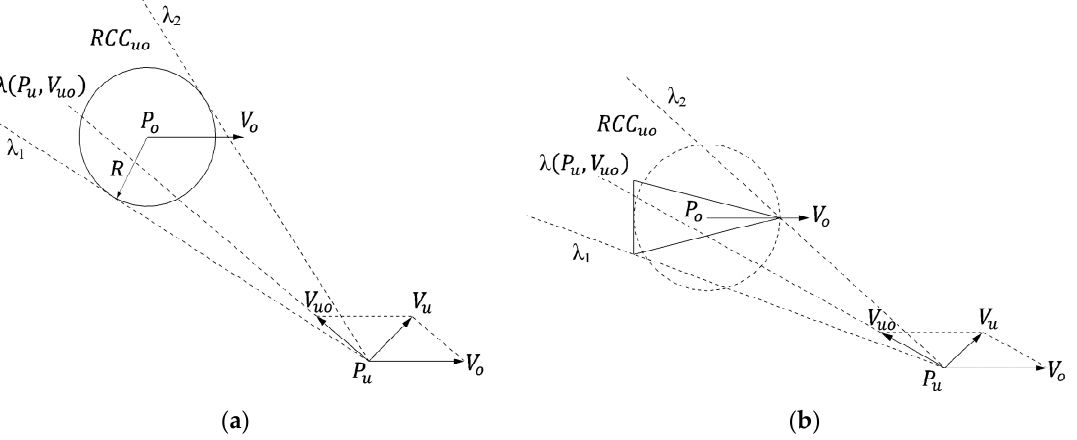
Figure 1. Comparison of dynamic ship collision domains with velocity obstacle method: ( a ) tradi- tional dynamic ship collision domain; ( b ) improved dynamic ship collision domain.